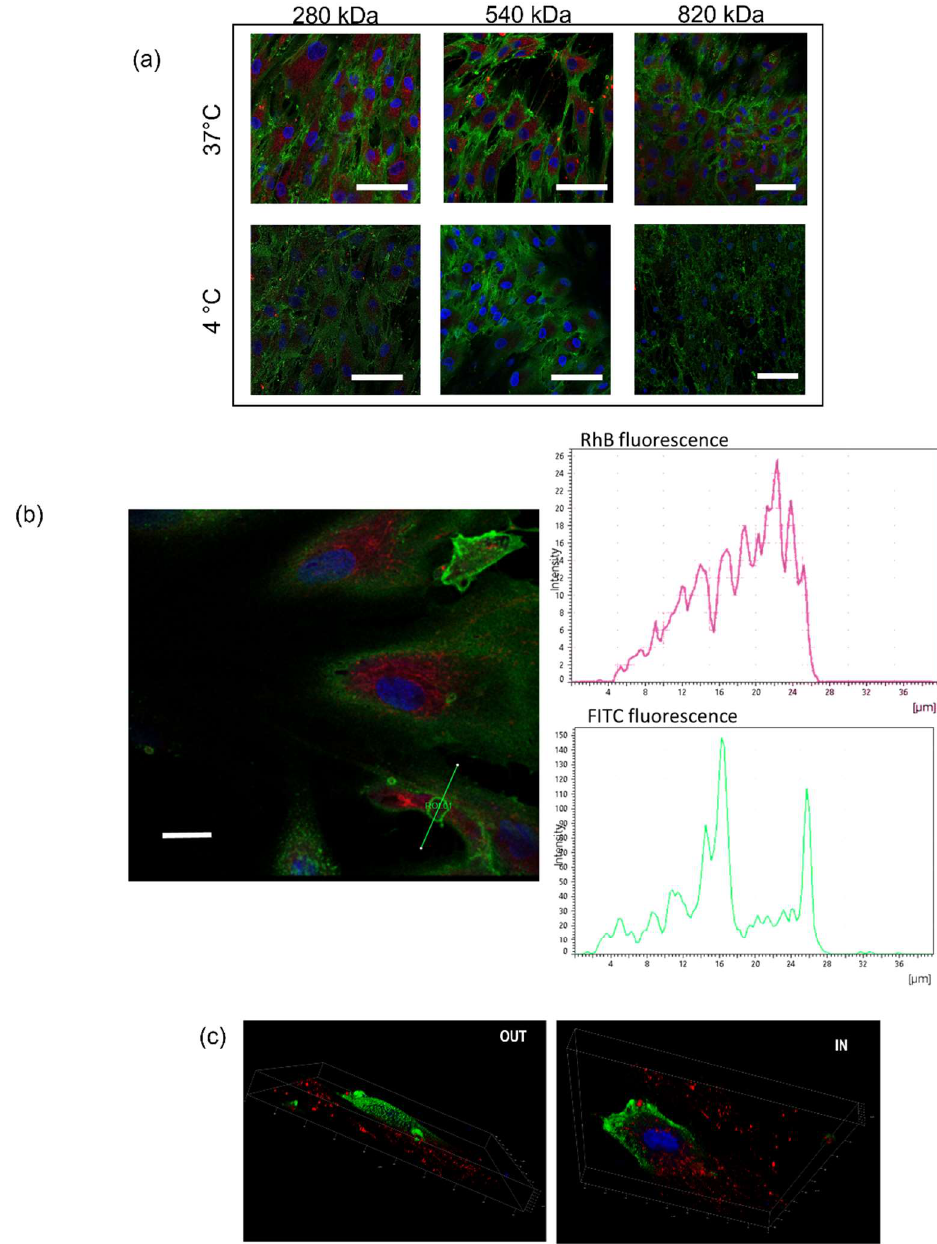
Figure 4. ( a ) Confocal microscopy images of hMSCs following the incubation with HA/CS-RhB NPs (20 µg for each HA) at 37 °C and 4 °C for 90 min. Red fluorescence denotes HA/CS NPs; blue Hoechst33258 dye stained DNA in the nuclei; positive expression for CD44 was highlighted by anti-CD44 primary antibody and FITC labeled secondary antibody (green fluorescence); (scale bar = 50 µm). ( b ) Confocal image of hMSCs incubated for 90 min with HA/CS-RhB NPs (280 kDa HA) and analysis of the red (RhB) and green (FITC) fluorescence intensities measured along the yellow line crossing the endocytic vesicles (scale bar = 20 µm). ( c ) Three-dimensional images of hMSCs treated with HA/CS-RhB NPs (820 kDa HA).